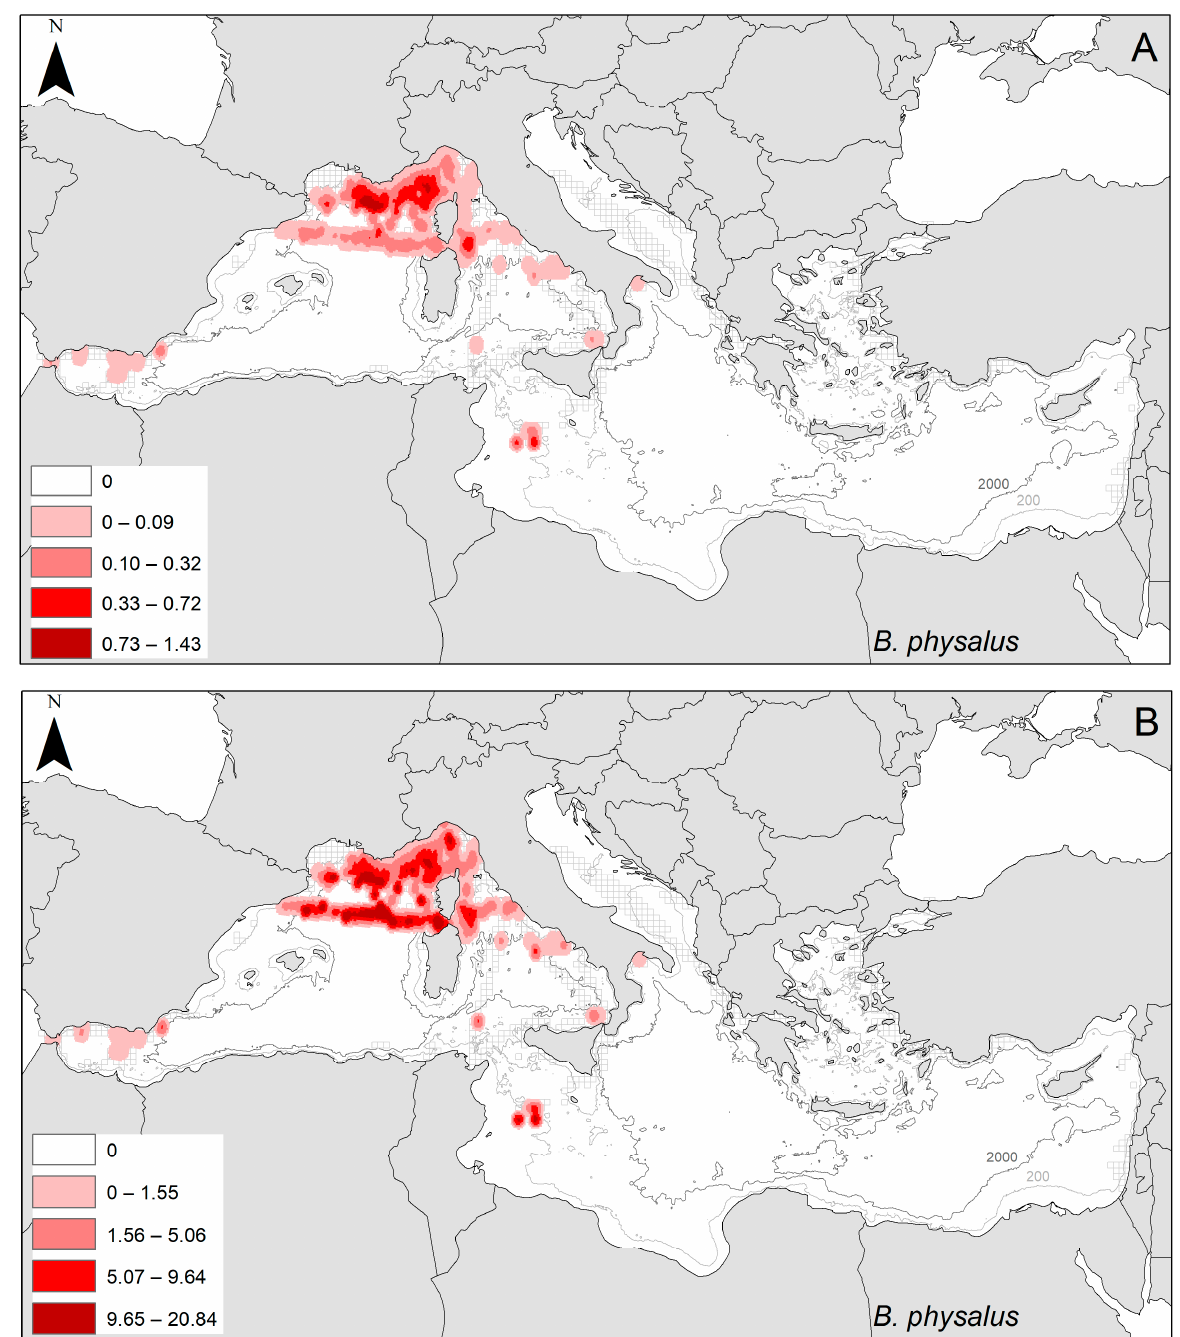
The prevalence map ( B ) confirms this pattern of presence and distribution within the Mediterranean basin (Kernel density parameters: cell size x, y = 5 × 5 km; radius ≈ 30 km; criterion for division into classes: natural breaks).